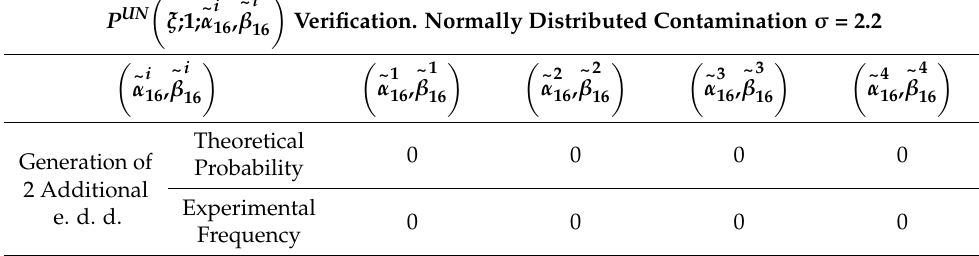
(cid:16) (cid:17) ξ ,1; (cid:101) α i , (cid:101) β i , namely for the case where # edd 16 16 (cid:16) (cid:17) (cid:0) (cid:1) − ι # edd (cid:101) β ι 16 (cid:101) γ 16